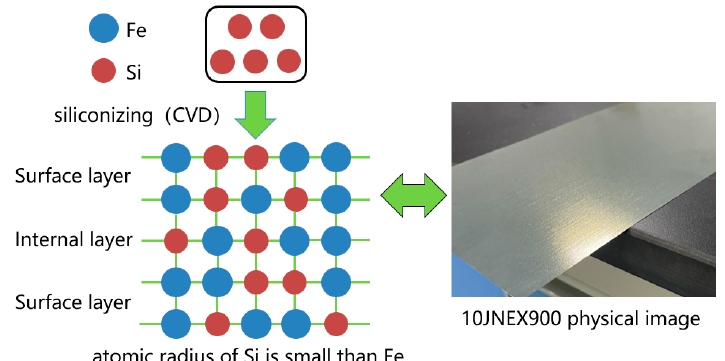
Figure 2. 10JNEX900 CVD process and physical schematic diagram.